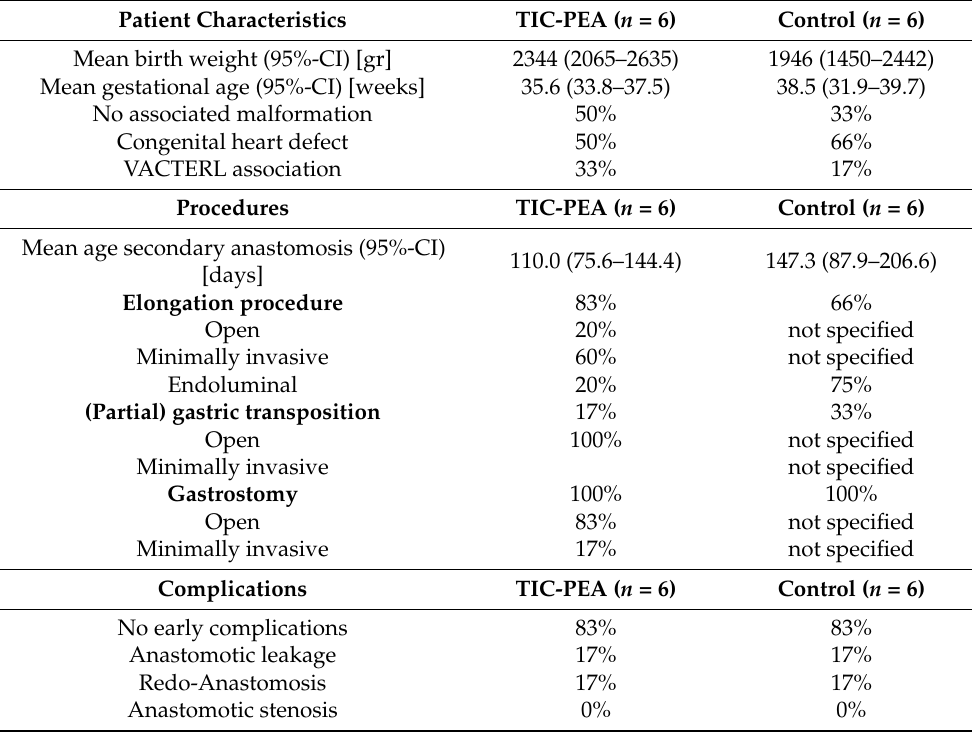
Table 2. Comparison of patient characteristics, procedures and complications for TIC-PEA patients and controls with EA (Gross Type